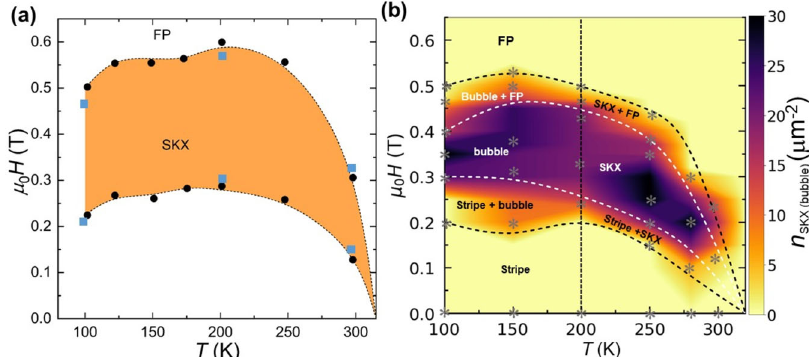
Fig. 6 Phase diagrams. a H – T phase diagram constructed using the magnetization data of polycrystalline Mn 4 Ga 2 Sn sample. The critical fi elds for constructing the phase diagram are taken from the point of anomaly in the M ( H ) measurements ( fi lled circles) and ac susceptibility data ( fi lled squares). b H − T phase diagram for Mn 4 Ga 2 Sn, as deduced from the temperature and fi eld dependent Lorentz transmission electron microscopy (LTEM) measurements of the sample at nearly 4 degree tilting condition. The color contrasts represent the average numbers of skyrmions ( n SKX ) and type-II bubbles in each μ m 2 area. The asterisk symbols correspond to the point ( H and T ) where images are recorded. H corresponds to the magnetic fi eld and μ 0 is the permeability of vacuum. SKX and FP correspond to skyrmion and fi eld polarized, respectively.